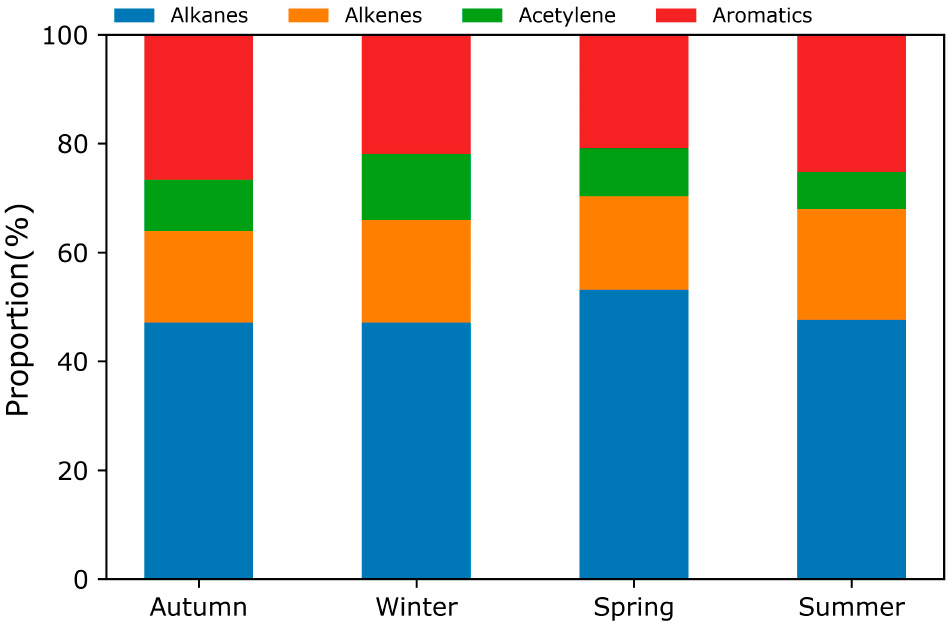
Figure 2. The seasonal proportions of different hydrocarbons.